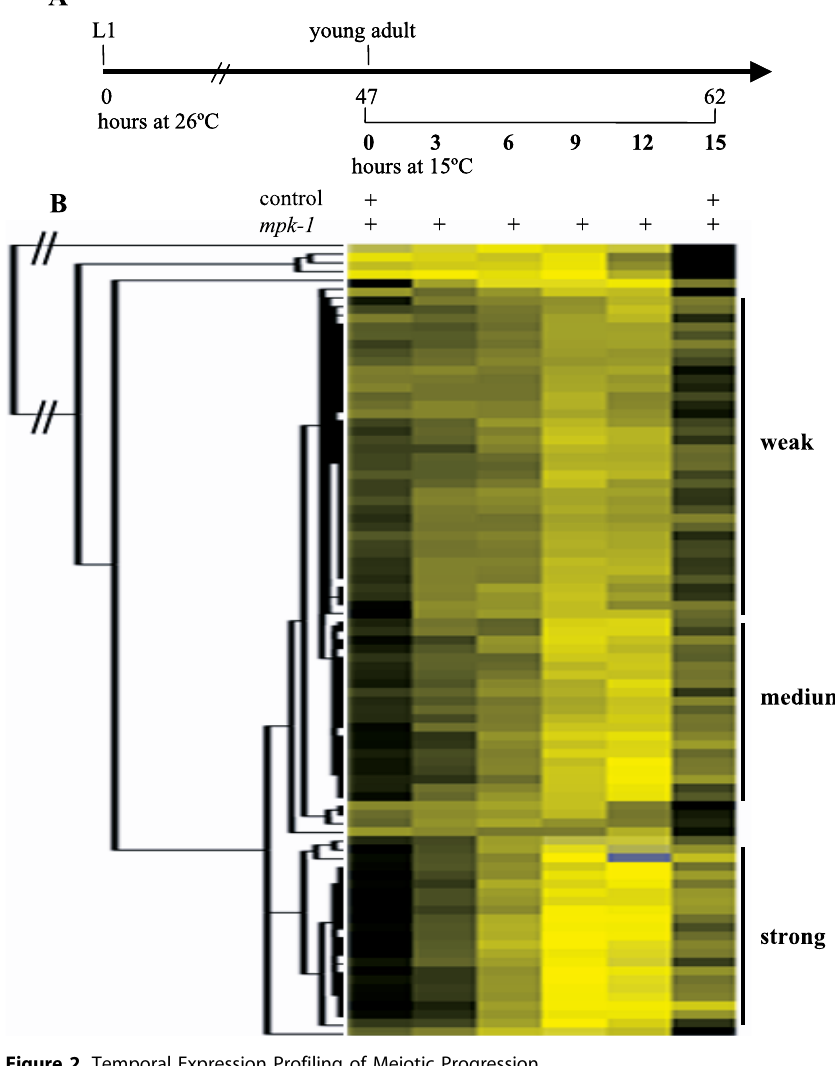
Figure 2. Temporal Expression Profiling of Meiotic Progression (A) Adults were shifted to permissive temperature (47 h after hatching) and subsequently analyzed at indicated times. (B) Hierarchical clustering analysis of expression profiles upon resumption of MPK-1 signaling. Each column represents the mean of three replicates for each time sampled. Each row represents one of 90 genes with enriched expression in control compared with mpk-1 at 0 h. Low expression in mpk-1 relative to the control (black) is evident at 0 h, with increasing expression as meiotic progression resumes (yellow). Three major clusters, each with an expression correlation . 0.95, are indicated (strong, medium, and weak).